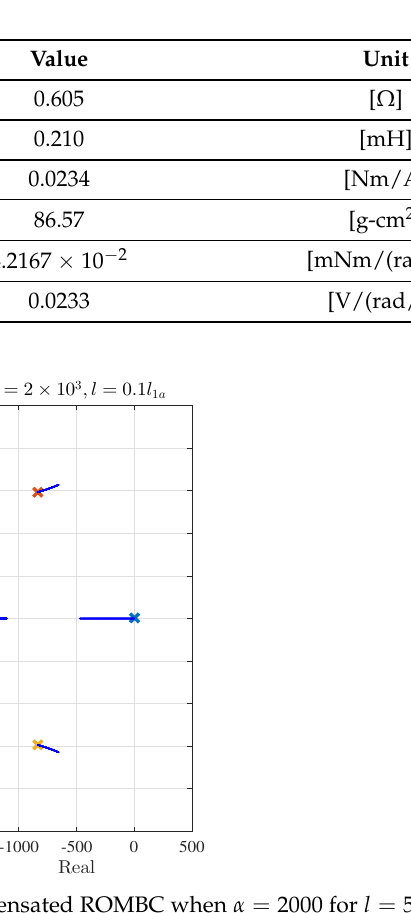
Figure 5. Root trajectories of ROPIO compensated ROMBC when α = 2000 for l = 5000 ( left ) and l = 0.1 l 1 a = 463.95 ( right